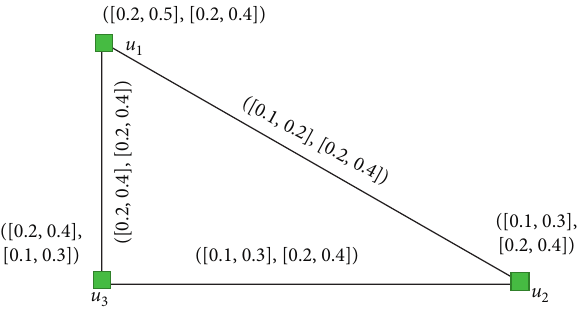
Figure 3: Interval-valued intuitionistic fuzzy graph.